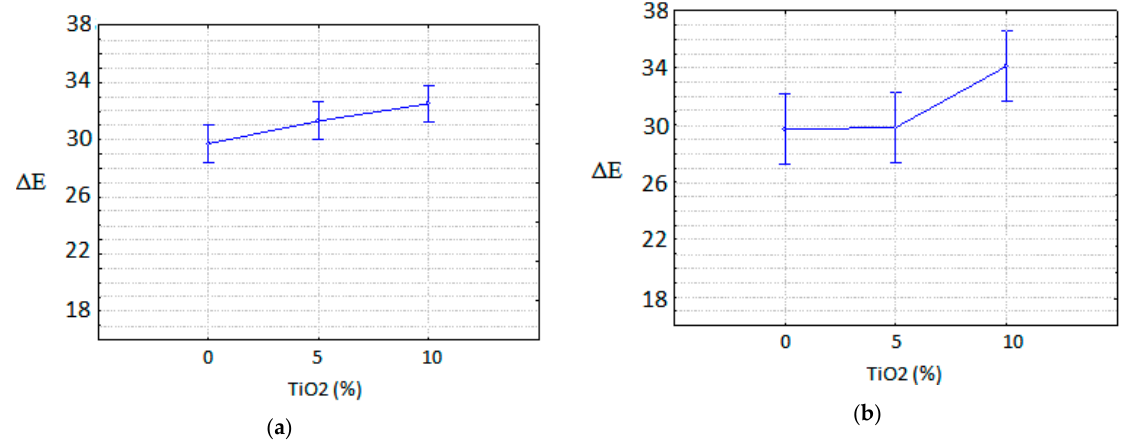
Figure 8. Analysis of the influence of TiO ₂ content, with and without staining by methylene blue, cured in an urban environment over time: ( a ) rutile, ( b ) anatase.